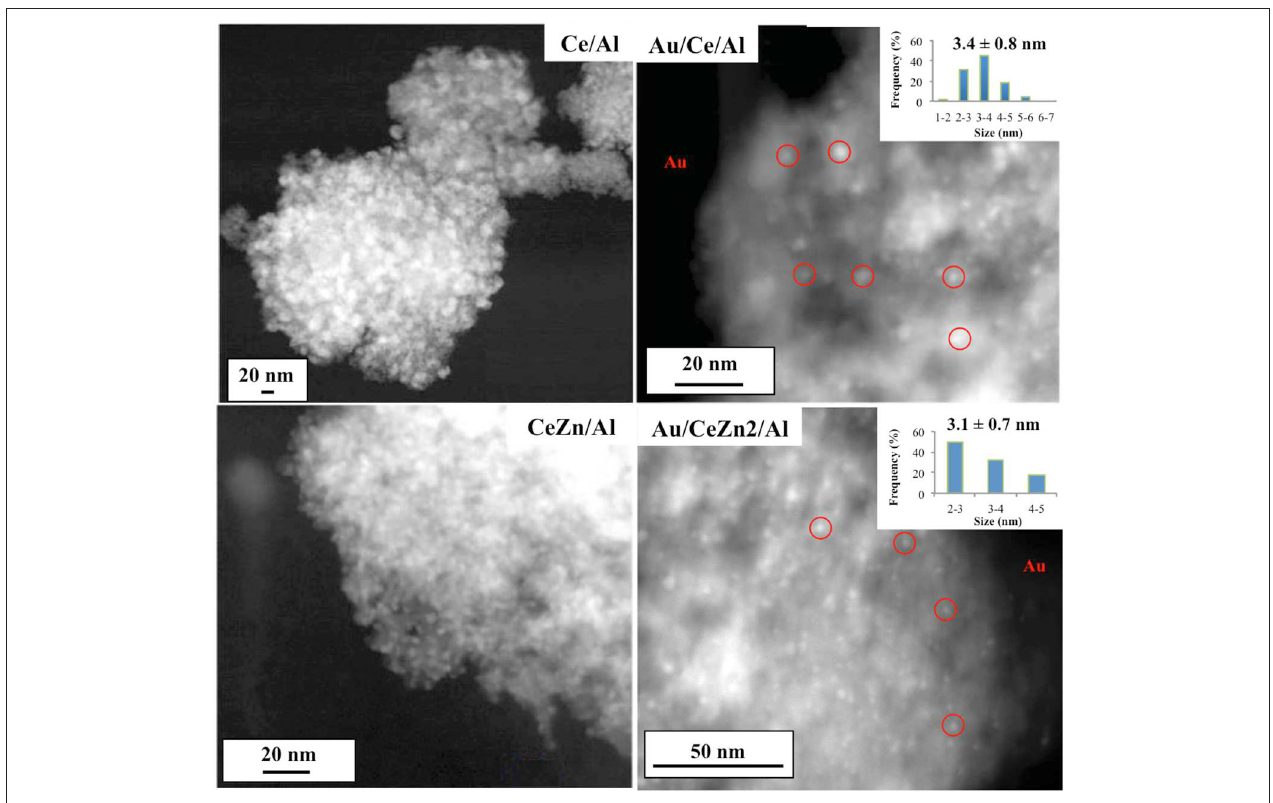
FIGURE 2 | Representative images of supports and catalysts.